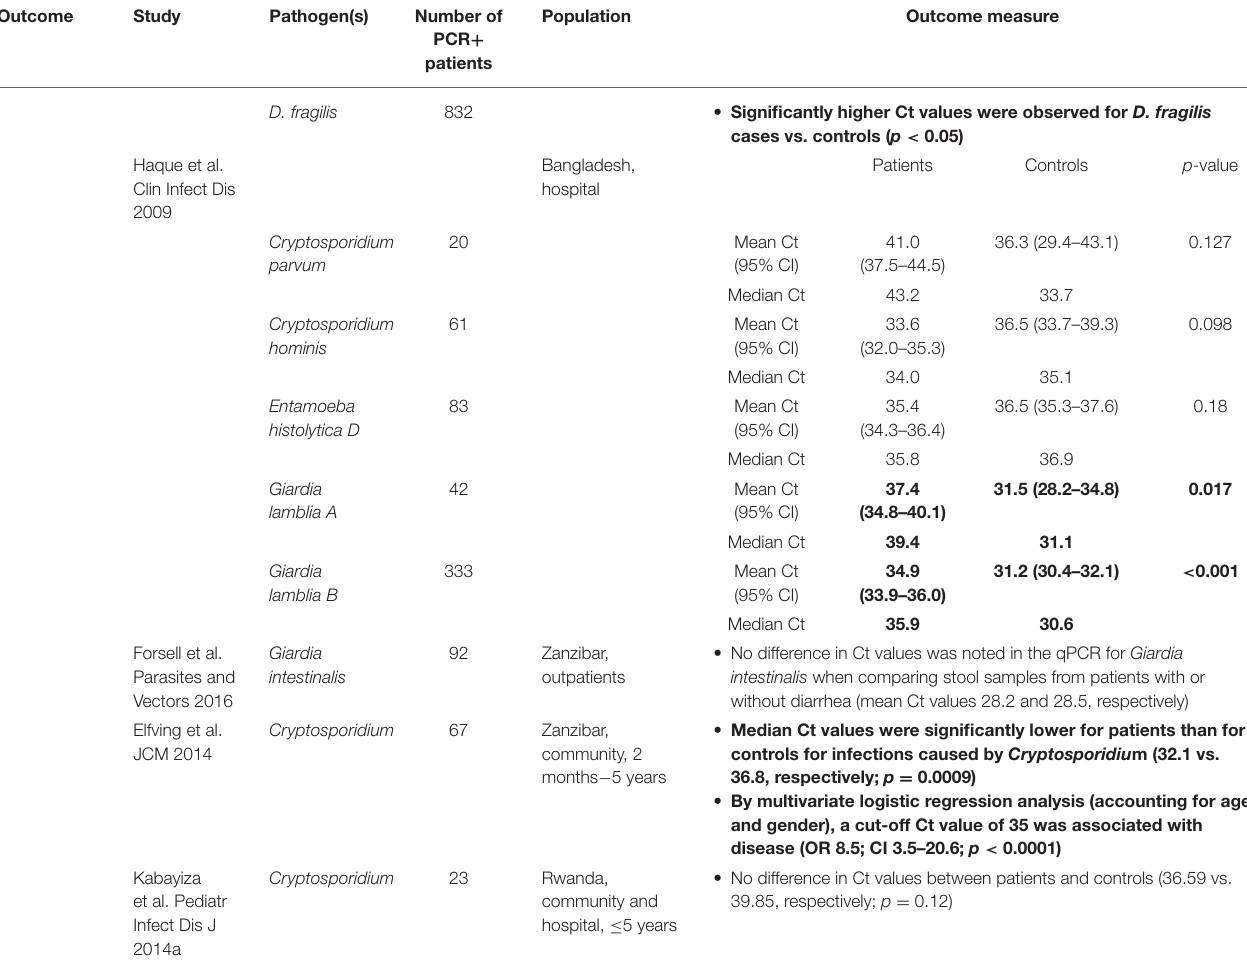
CI, confidence interval; Cp, crossing point; Cq, quantification cycle; Ct, cycle threshold; EAEC, enteroaggregative E. coli; EIEC, enteroinvasive E. coli; EPEC, enteropathogenic E. coli; ETEC, enterotoxigenic E. coli; IV, intravenous; OR, odds ratio; PCR, polymerase chain reaction; qPCR, quantitative polymerase chain reaction; ROC, receiver operating characteristic; STEC, Shiga toxin-producing E. coli; UK, United Kingdom. * Total number of matched pairs; individual pathogen PCR + ve n values were not provided, 2,254 samples were positive for one diarrhea-associated pathogen, and 2,063 samples were positive for ≥ 2. Bold indicates a statistically significant